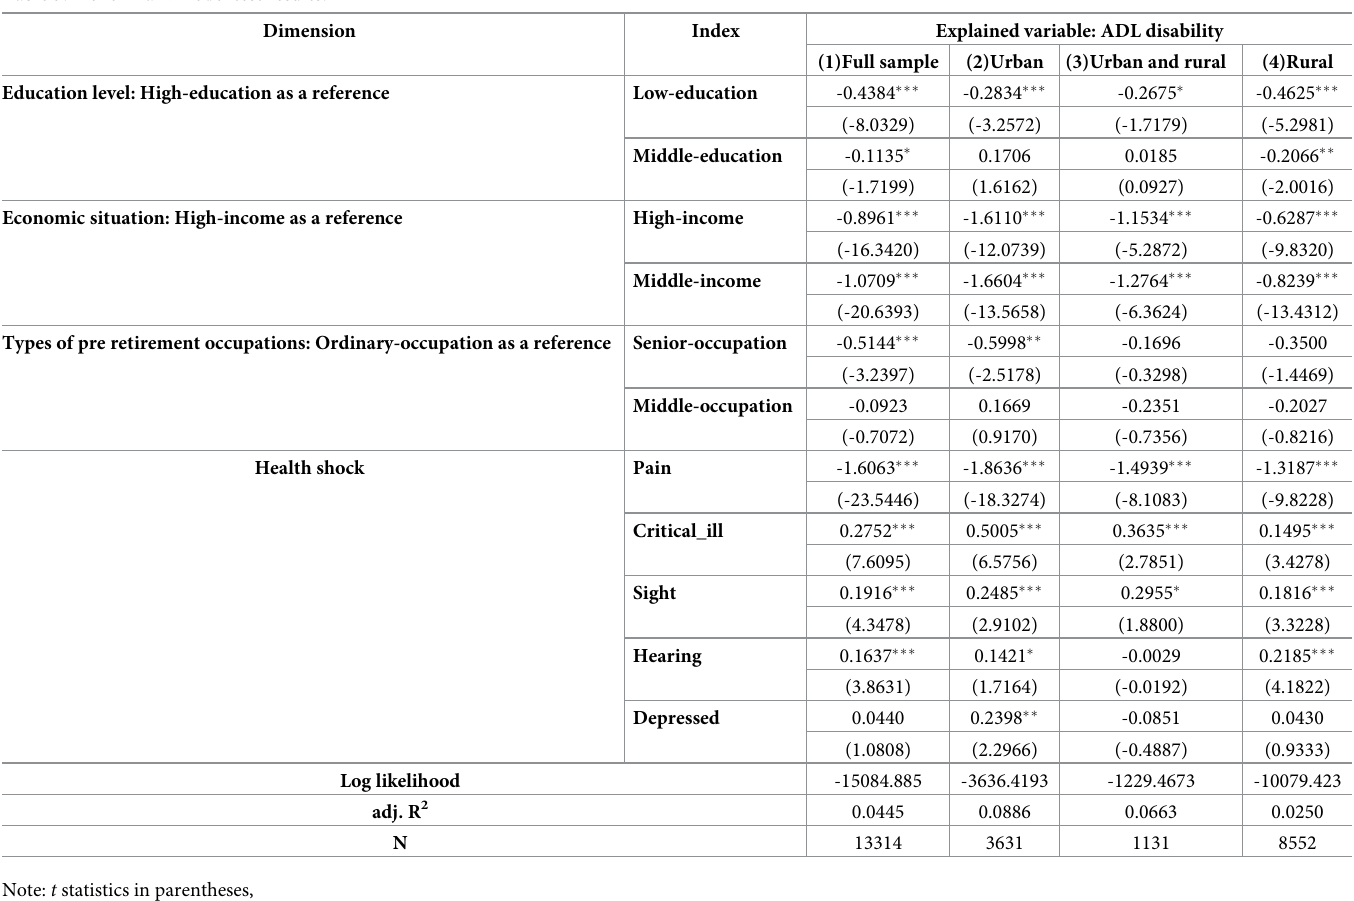
Table 3. Benchmark model test